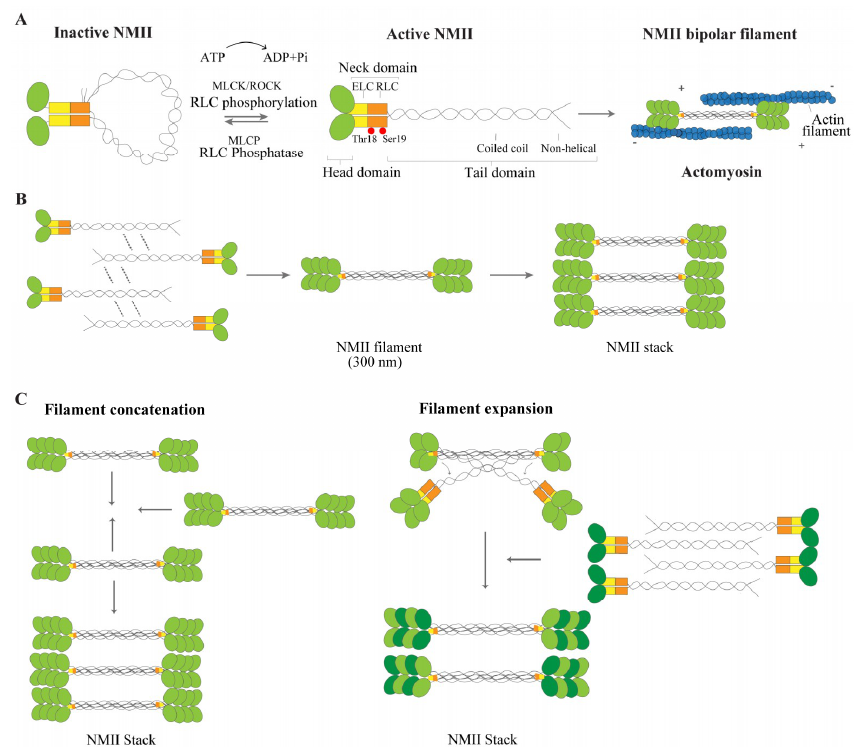
Figure 1. Non-muscle myosin II (NMII) structure and regulation. ( A ) NMII contains two heavy chains (HC), two regulatory light chains (RLCs) (orange) and two essential light chains (ELCs) (yellow). The heavy chain includes the head domain (green), with an actin binding site and an ATPase motor domain, the neck domain to which the ELC and RLC are bound, and the tail domain, with a helical coiled coil rod filament and a non-helical tail. In the absence of RLC phosphorylation, NMII is in an inactive conformation (left). Upon RLC phosphorylation by MLCK or ROCK, for instance, NMII unfolds to generate an active conformation (middle). MLCK phosphorylates RLC on Ser19 and Thr18, depicted as two red circles. The RLC phosphatase MLCP can revert this activation. NMII is then able to assemble into bipolar filaments, which bind to actin (blue) (right). ( B ) Upon NMII activation, polymerization-competent NMII molecules can form bipolar filaments through electrostatic interactions of their rod domains. Addition of more NMII molecules drives the growth of a bipolar NMII filament. For a matter of simplicity, a smaller number of myosins than that generally found on each side of the filament is drawn. ( C ) NMII filaments can also form super structures, the NMII stacks. Two models are considered to underlie NMII stack formation: Filament concatenation (left) and filament expansion (right). In the model of filament concatenation, NMII stacks can be formed through concatenation of multiple NMII filaments. In the model of NMII filament expansion, after the formation of the bipolar NMII filament, certain subset of daughter myosins separate themselves from one side of the filament, being each one used as a template. Growth of new templates is driven by addition of NMII